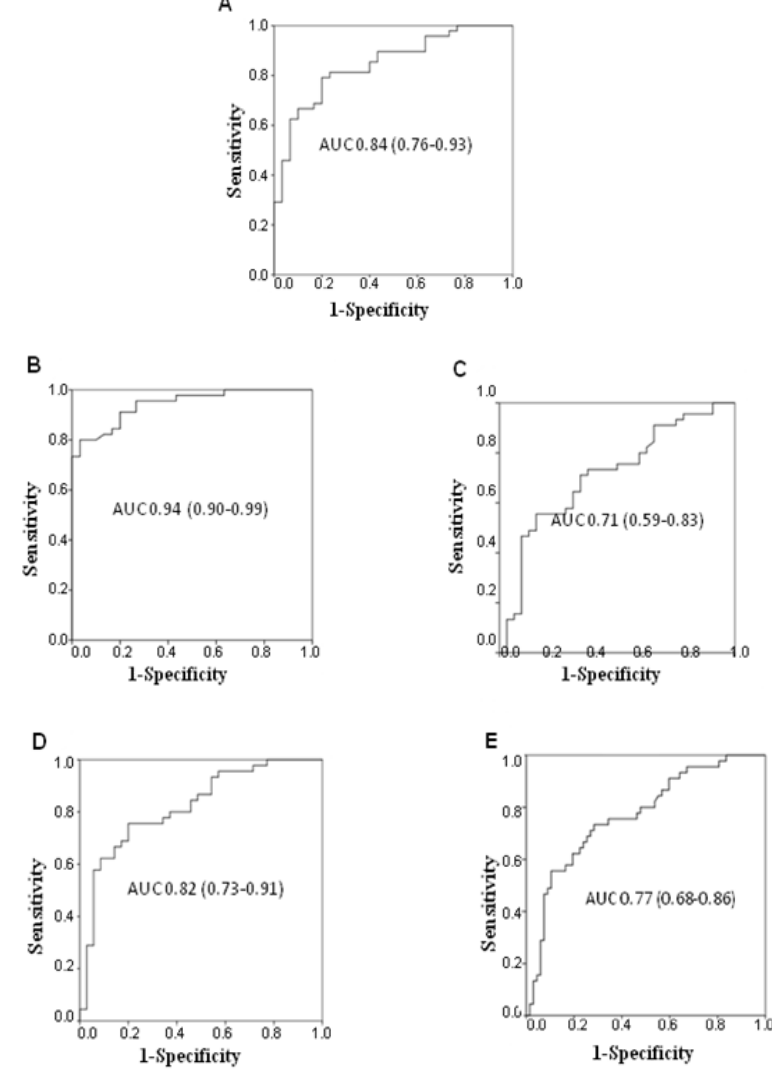
Figure 4. Diagnostic accuracy of serum MMP-7 levels in discriminating between non-small cell lung cancer patients and ( A ) healthy donors, and between idiopathic pulmonary fibrosis patients and ( B ) healthy donors; ( C ) non-specific interstitial pneumonia patients; ( D ) individuals with other non-malignant lung diseases; and ( E ) non-specific interstitial pneumonia patients together with individuals with other non-malignant lung